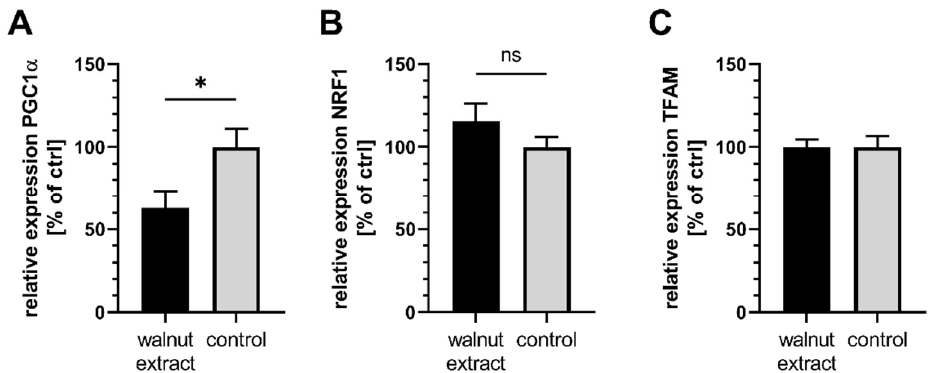
Figure 3. Effects of 10 µg/mL walnut lipid extract on gene expression of markers of mitochondrial biogenesis. EtOH-12%BSA mixture served as control. ( A ) Gene expression of PGC1 α ; n = 10. ( B ) Gene expression of NRF1; n = 10. ( C ) Gene expression of TFAM; n = 10. To evaluate statistical significance, a student’s t -test was performed in ( A , B ), while a Mann-Whitney test was performed in ( B ) due to data not fulfilling normality according to a Shapiro–Wilks test. Significant differences are displayed as: ns p ≥ 0.05, * p < 0.05. Results displayed as means ± SEM.